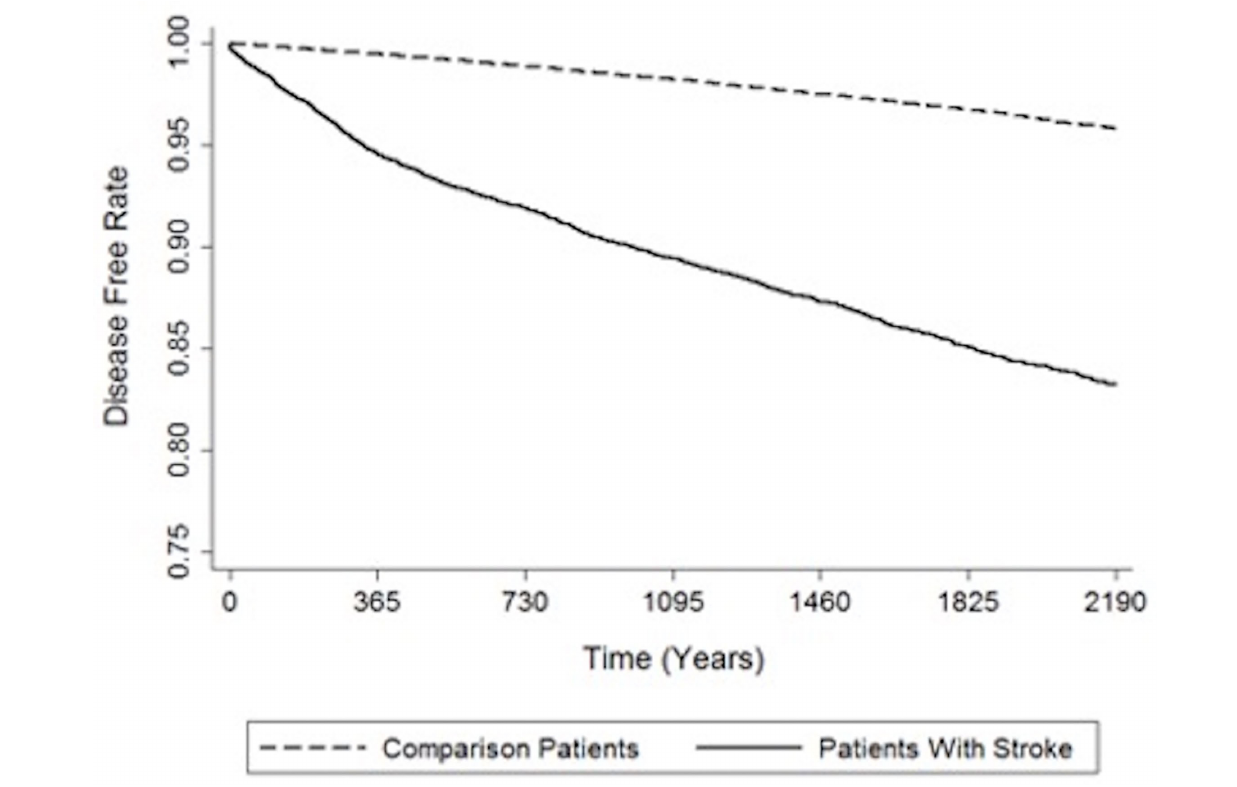
Frontiers in Neurology |